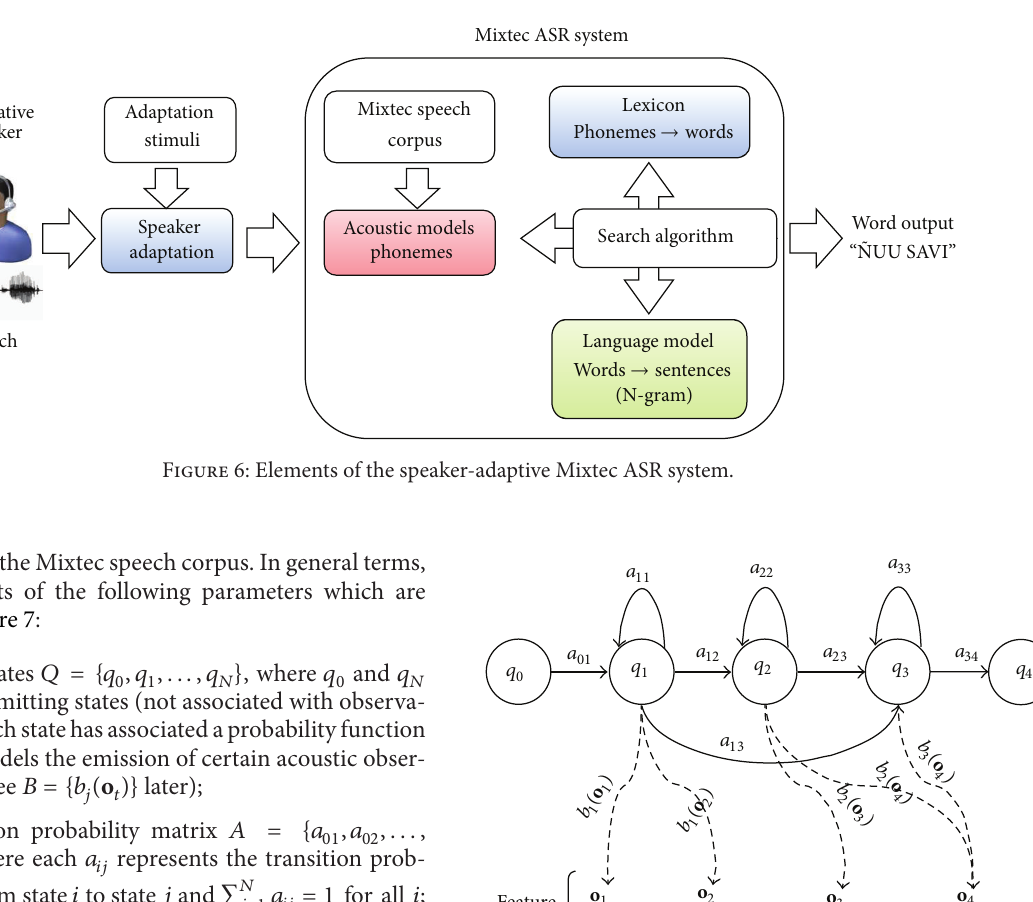
Figure 5: Frequency distribution of phonemes in the Mixtec speech corpus.